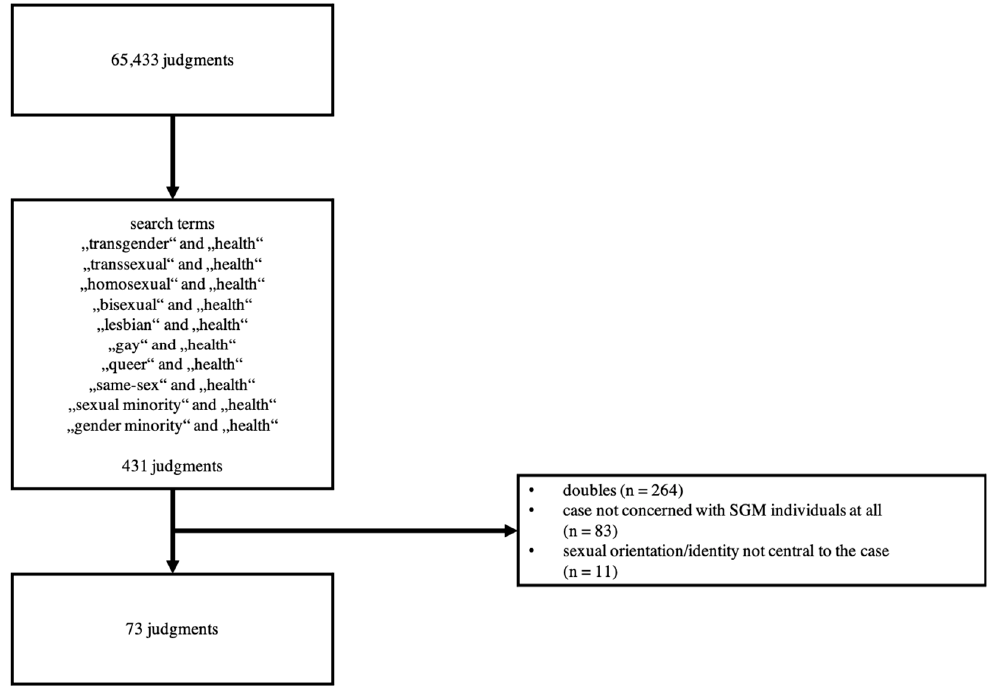
Figure 1. Flowchart of the search.